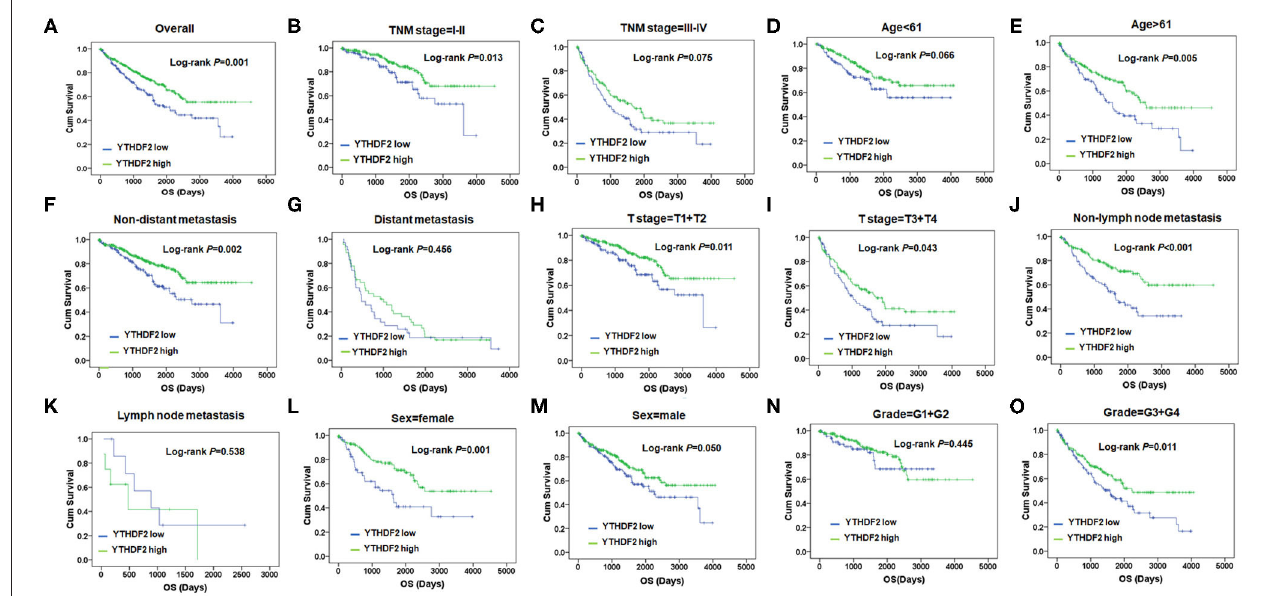
FIGURE 1 | YTHDF2 expression is associated overall survival (OS) with clinicopathological characteristics in clear cell renal cell cancer (ccRCC). (A) Kaplan–Meier survival analysis and log-rank test were used to compare differences in OS between the groups classified using cutoff values determined by X-tile; Kaplan–Meier survival analysis and log-rank test were used to analyze the association of YTHDF2 expression and OS stratified by TNM stage (B,C) ; age (D,E) ; non-distant metastasis (F) , distant metastasis (G) ; T-stage = T1 + T2 (H) ; and T-stage = T1 + T2 (I) ; non-lymph node metastasis (J) and lymph node metastasis (K) , sex (L,M) ; and grade = G1 + G2 (N) and grade = G3 + G4 (O) .